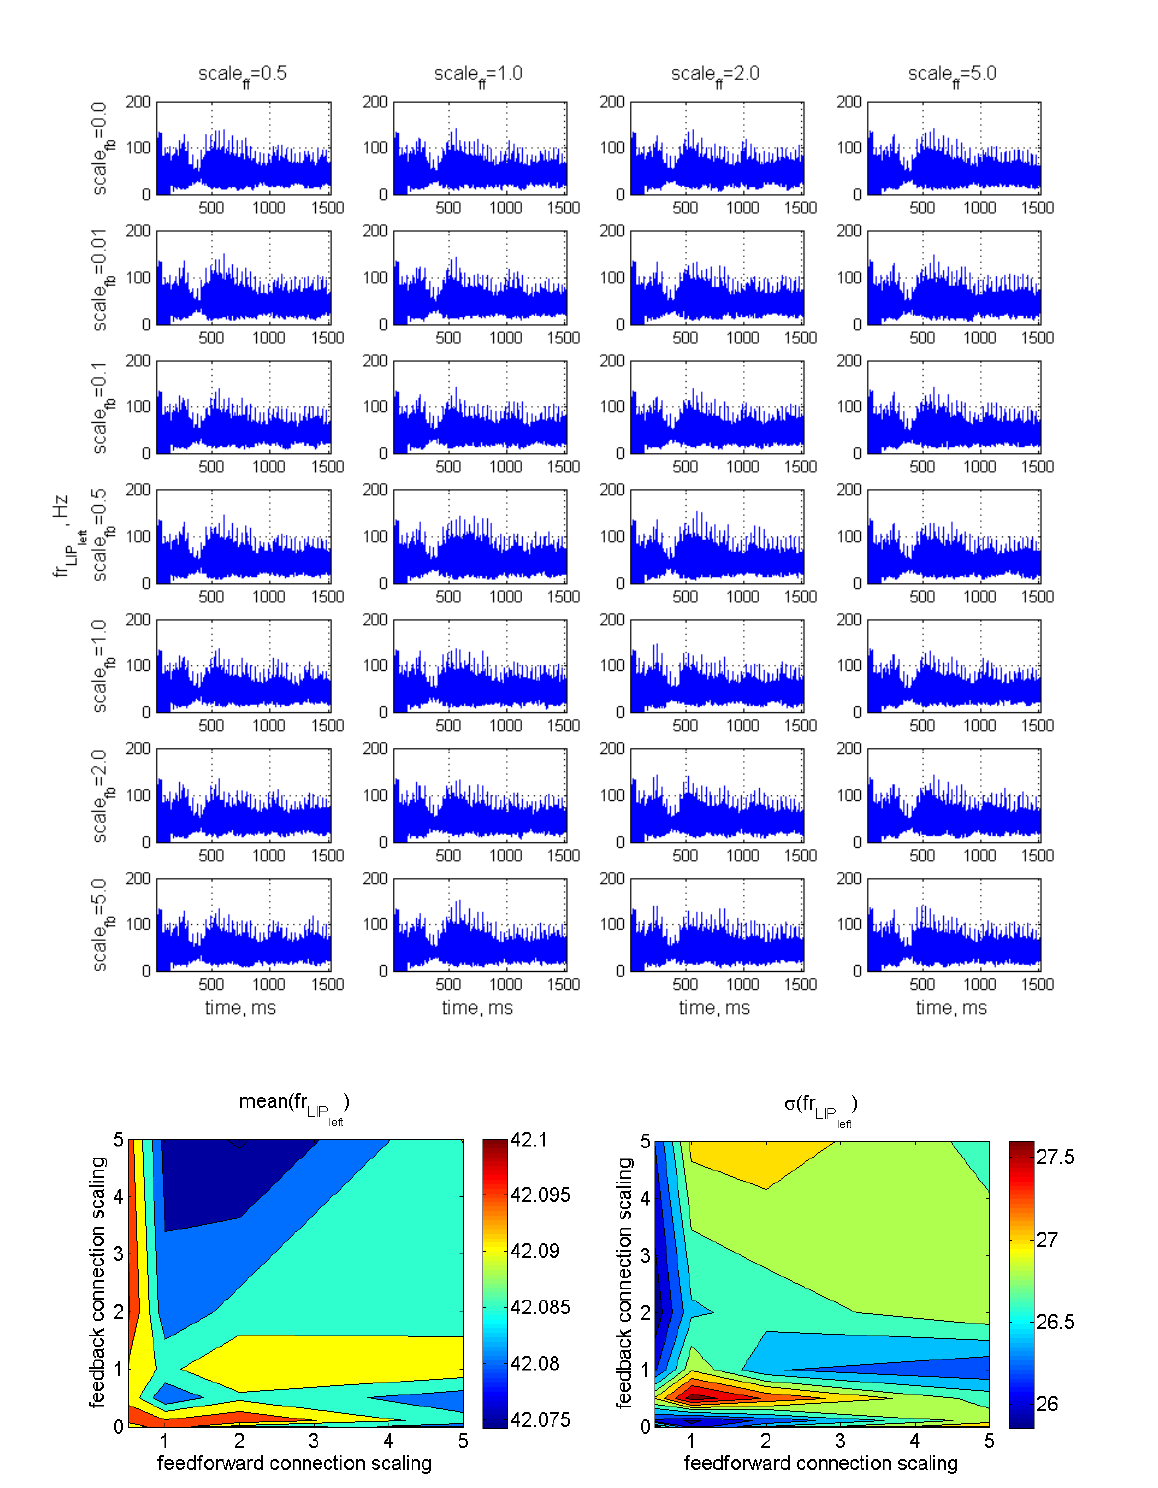
Fig. 7. Spiking activity in LIP left and its mean (bottom left) and variance (bottom right).